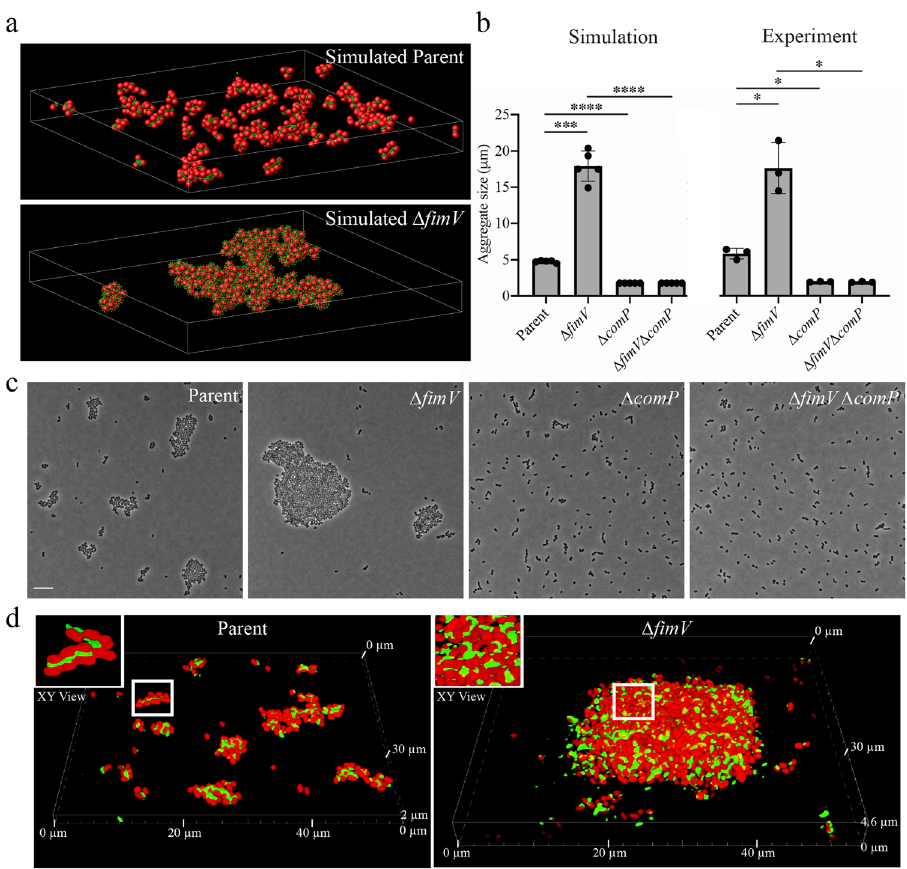
Fig. 4 | T4P localization controls multicellular interactions in A. baylyi . a Representative images of simulated data for modeled cellular objects with dif- ferent patterns of adhesin localization. b Quanti fi cation of multicellular aggregate sizesfromsimulatedorexperimentaldatacollectedforindicatedstrains.Eachdata point represents a simulation ( n =5) or biological ( n =3) replicate and bar graphs indicatethemean±SD.Statisticalcomparisonsweremadeusingtwo-tailedWelch ’ s t -test: * P <0.05; *** P <0.001; **** P <0.0001. Exact measurements and P values are